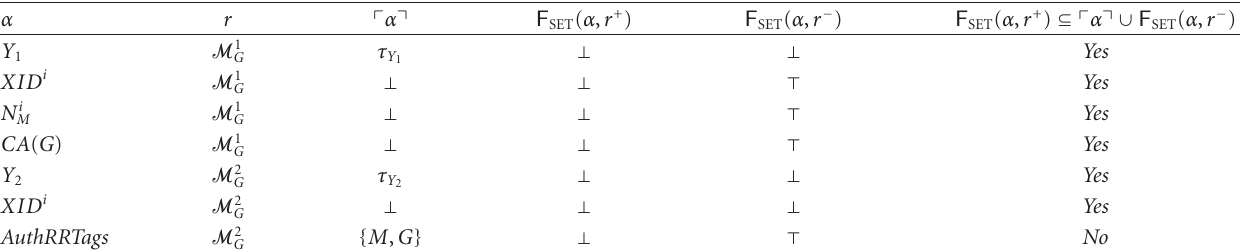
Table 18: SET analysis: role of M